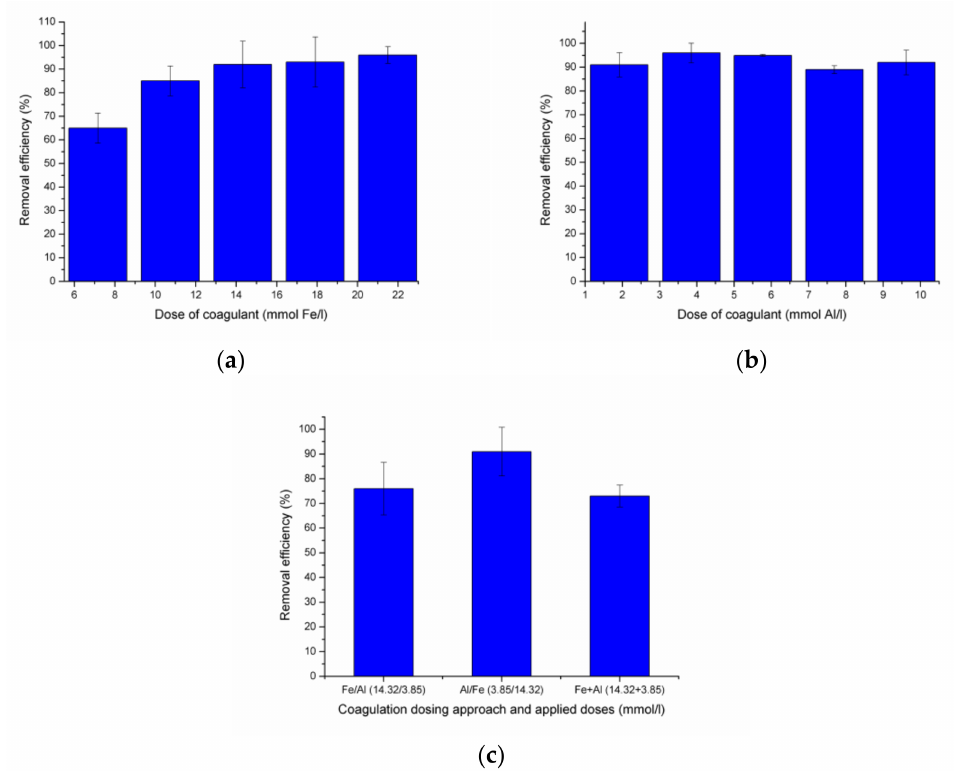
Figure 10. Efficiency of removal of textile fibers from a laundry wastewater by coagulation with ( a ) FeCl 3 , ( b ) PACl, and ( c ) a combination of FeCl 3 and PACl (error bars show standard deviation of